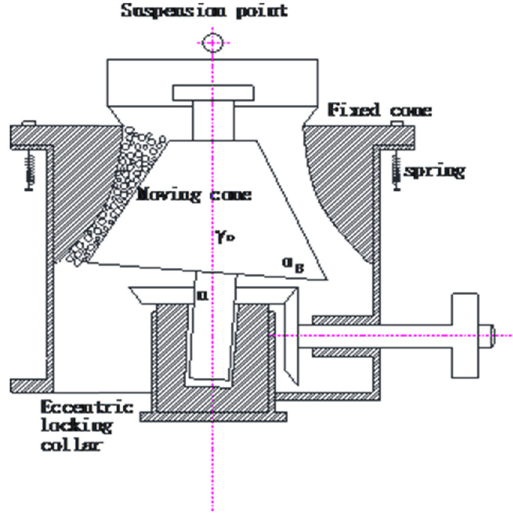
Figure 1: Diagram of a working cone crusher.